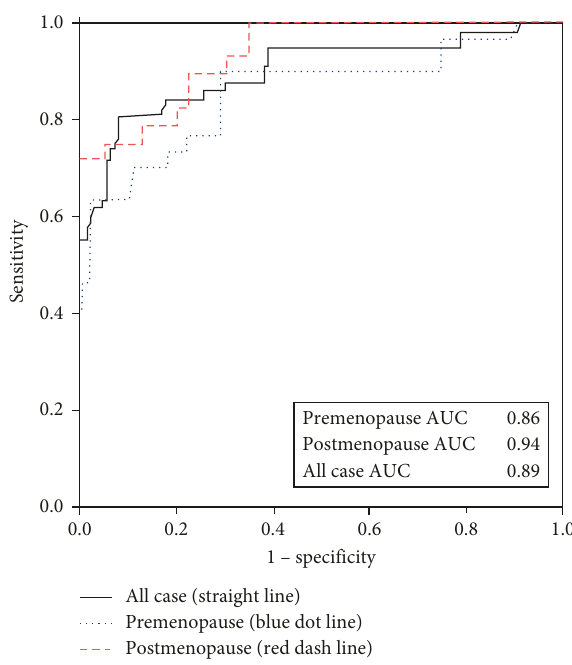
Figure 2: ROC curve of ROMA divided into premenopausal and postmenopausal